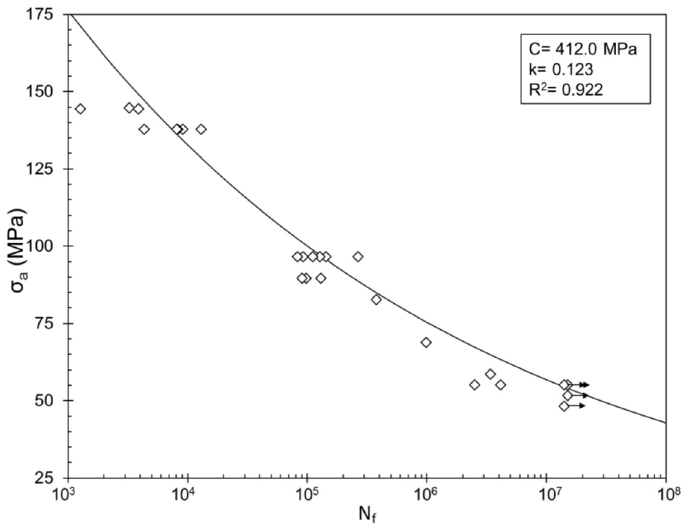
Figure 13. Relation between quality factor (mainly based on elongation) and fatigue life of cast 319 alloy